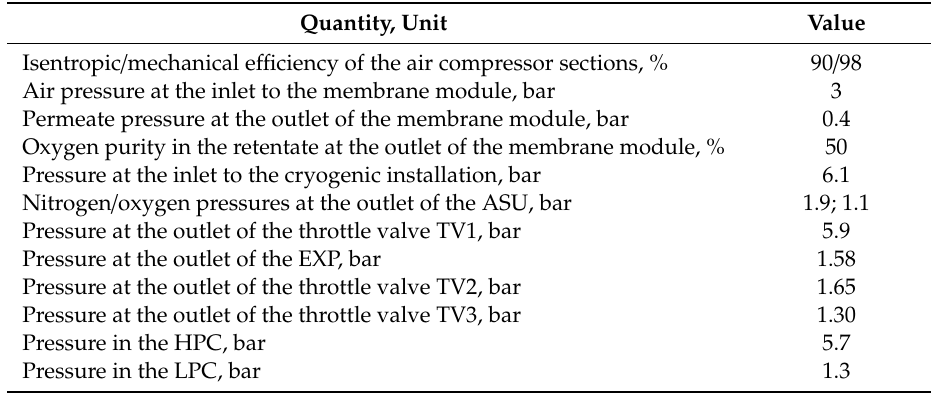
Table 4. Assumptions for the hybrid ASU (variant V2).